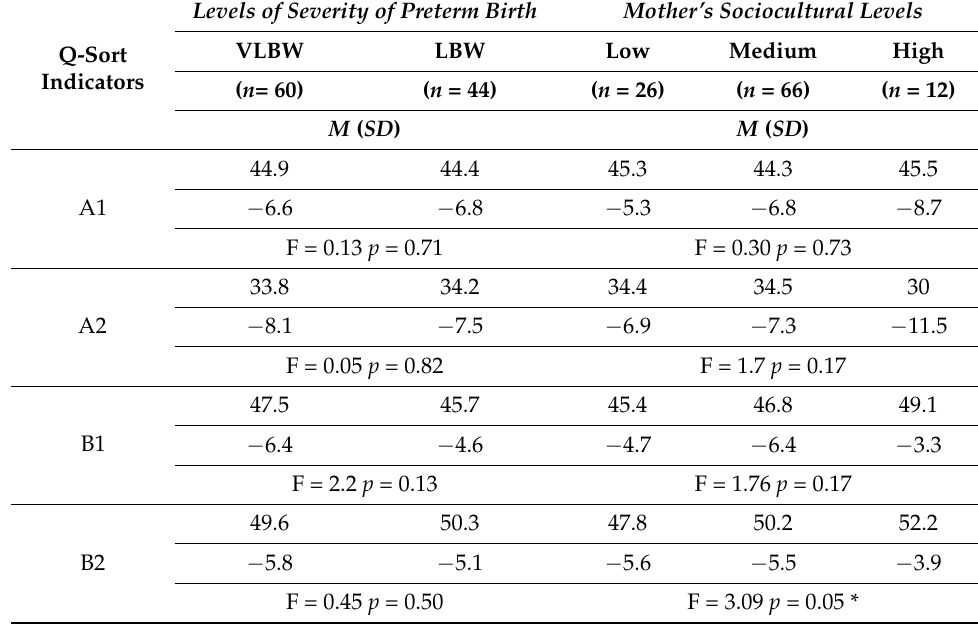
Table 8. Maternal competence (Q-sort scores) at the time of home (T2) in relation to levels of severity of preterm birth and mother’s sociocultural level (MANOVA) ( n = 104).